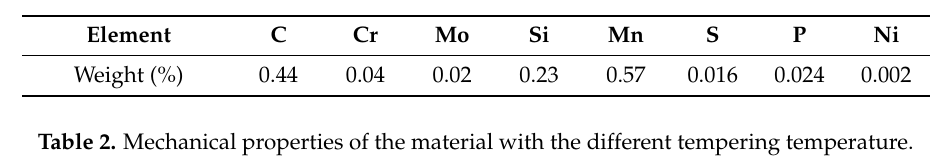
Table 1. Chemical composition of the material.